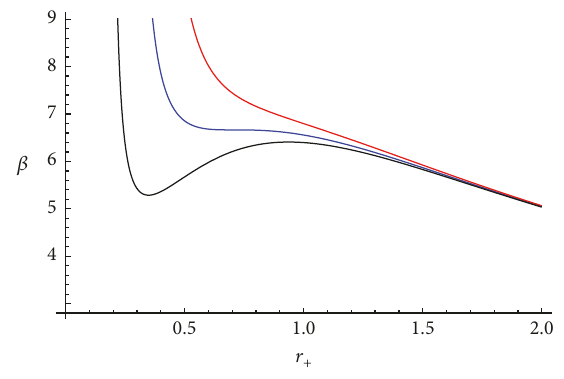
Figure 2: 𝛽 - 𝑟 + diagram when 𝑄 = 𝑄 𝑐 − Δ𝑄 (black), 𝑄 = 𝑄 𝑐 (blue), and 𝑄 = 𝑄 𝑐 + Δ𝑄 (red), with 𝑄 𝑐 = 𝑙/6 , 𝑙 = √3 , and Δ𝑄 = 0.1 . The blue curve in the middle represents the critical